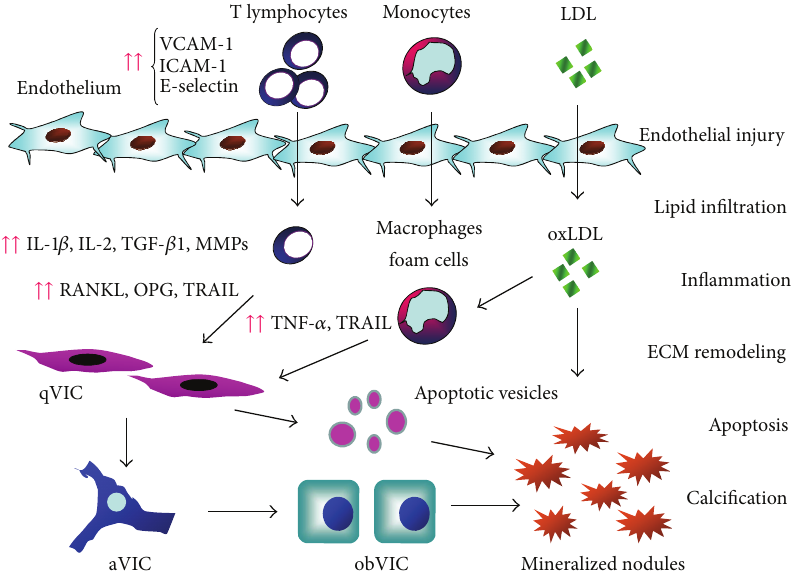
Figure 1: Mechanisms involved in calcific aortic valve disease. An endothelial injury or dysfunction causes increased expression of adhesion molecules, such as VCAM-1, ICAM-1, and E-selectin. Inflammatory cells such as T lymphocytes and monocytes are recruited, and they release cytokines and proteolytic enzymes, which stimulates the activation and differentiation of resident fibroblasts or quiescent valvular interstitial cells (qVICs) into myofibroblasts (activated VICs, aVICs) and osteoblastic VICs (obVICs) with consequent calcification. VICs also undergo apoptosis, and the formation of apoptotic vesicles contributes to calcification. Circulating lipids also enter the valvular interstitial tissue and undergo oxidative modification; the oxidized lipoproteins (oxLDL) are highly cytotoxic and stimulate inflammatory activity and